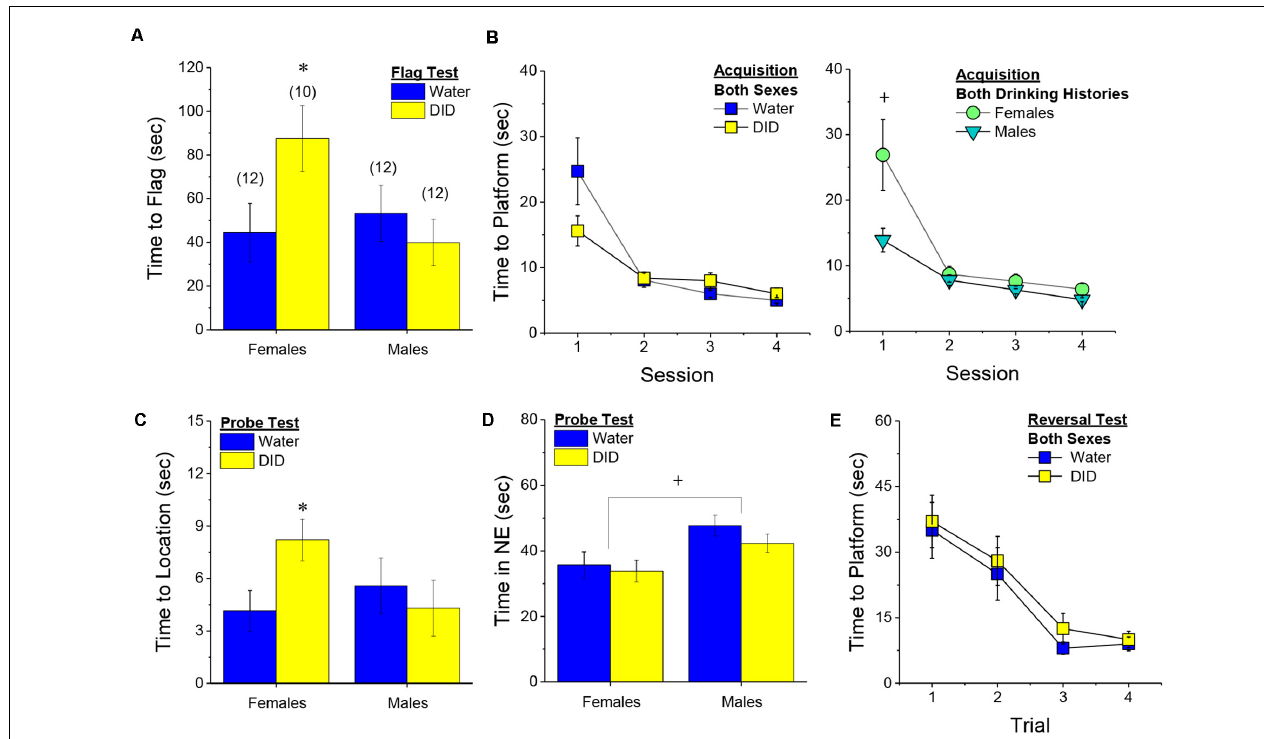
FIGURE 6 | Effects of binge drinking during later maturity (6 months of age) on Morris water maze performance in cohorts of isogenic C57BL/6J mice. (A) Relative to water-drinking controls (Water), binge drinking (DID) females in Experiment 2 exhibited a longer latency to locate a visible, flagged, platform. (B) All mice readily acquired the location of a hidden platform in the Morris Maze over the 4-day course of training, although DID mice tended to locate the platform more quickly than Water controls on Session 1 (left) , and males were significantly quicker than females on Session 1 (right) . (C) On the probe test, female DID mice exhibited a longer latency to first enter the former location of the hidden platform. (D) No binge drinking effects were detected for the amount of time spent in the NE quadrant that formerly contained the hidden platform, although males spent more time, overall, than females. (E) No group differences were detected for reversal learning when the hidden platform was relocated within the maze. The data represent the means ± SEMs of the number of mice indicated in parentheses in Panel (A) . ∗ p < 0.05 DID vs. Water; + p < 0.05, Females vs.